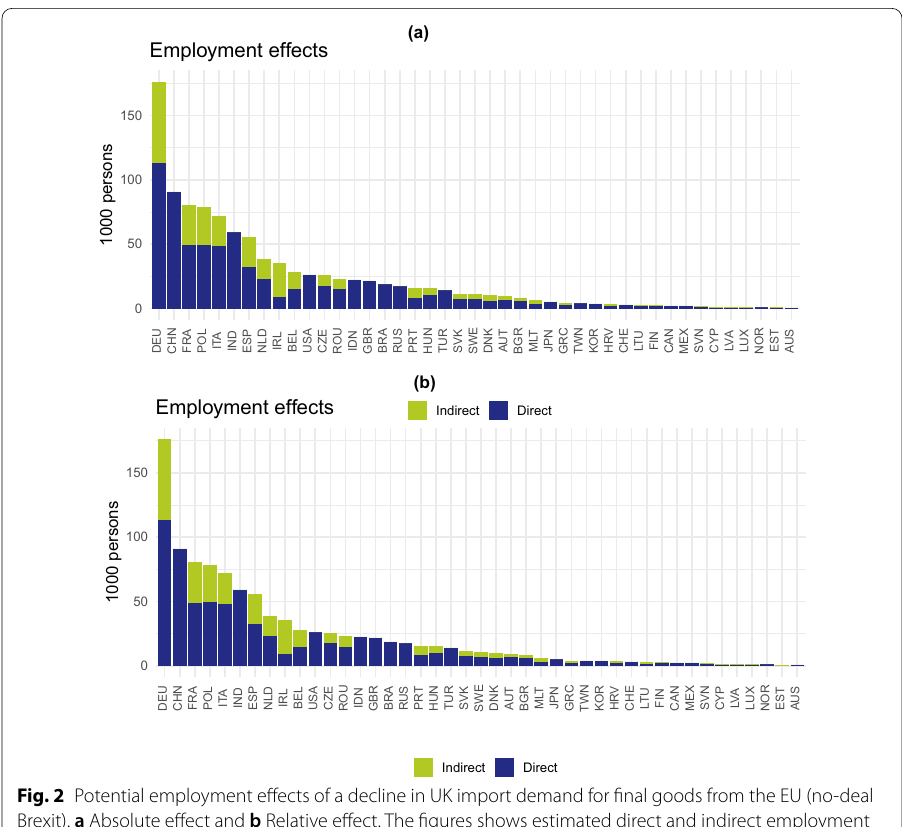
Fig. 2 Potential employment effects of a decline in UK import demand for final goods from the EU (no‑deal Brexit). a Absolute effect and b Relative effect. The figures shows estimated direct and indirect employment effects of a decline in British final goods imports due to tariffs and non‑tariff trade costs after a no‑deal Brexit derived from input–output analysis. General‑equilibrium effects and other relevant channels such as trade diversion are not included. Source: World Input–Output Database, data for 2014, and own